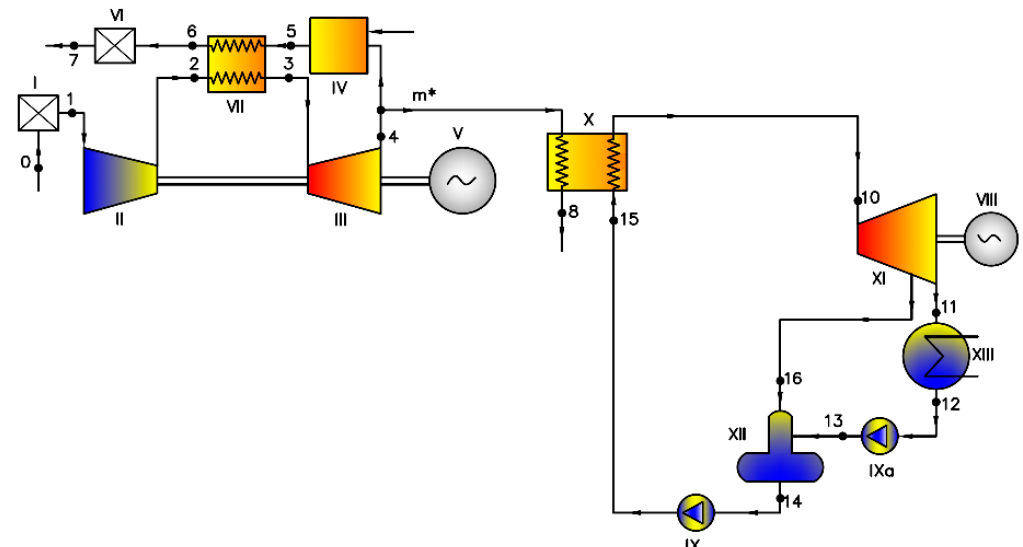
Figure 15. Circulation diagram with an air turbine, an external combustion chamber and a bypass with an additional steam circuit (Variant 5-V5). I–filter; II–compressor; III–turbine; IV–external combustion chamber; V–electric generator of gas turbine; VI–silencer; VII–regenerator; VIII- electric generator of steam turbine; IX–main pump; IXa–condensate pump; X–heat recovery steam generator; X1–steam turbine; XII–direct contact heat exchanger; XIII–condenser.